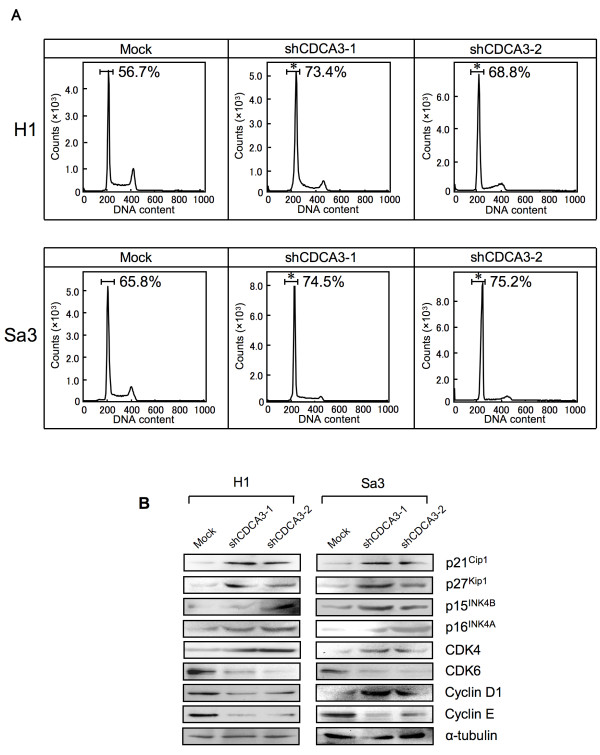
Flow cytometric determination of DNA content in shCDCA3- and mock-transfected cells. A) Representative FACS analysis shows that the number of cells in the G1 phase is significantly (*p < 0.05, Mann-Whitney’s U test) increased in shCDCA3-transfected H1 and Sa3 cells. B) Western blot analysis of CDKIs (p21Cip1 p27Kip1, p15INK4B, and p16INK4A), CDK4, CDK6, Cyclin D1, and Cyclin E shows up-regulation of p21Cip1, p27Kip1, p15INK4B, p16INK4A, CDK4, and Cyclin D1, and down-regulation of CDK6 and Cyclin E in the CDCA3 knockdown cells